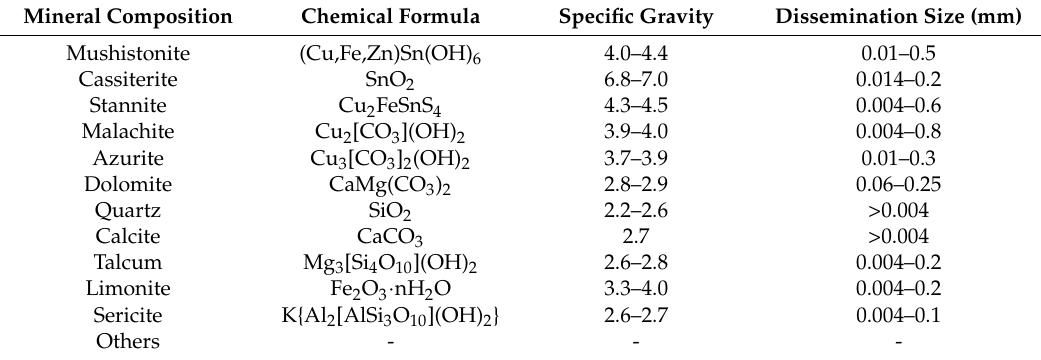
Table 1. Mineral composition, chemical formula, specific gravity, and dissemination size of the raw ore. Mineral